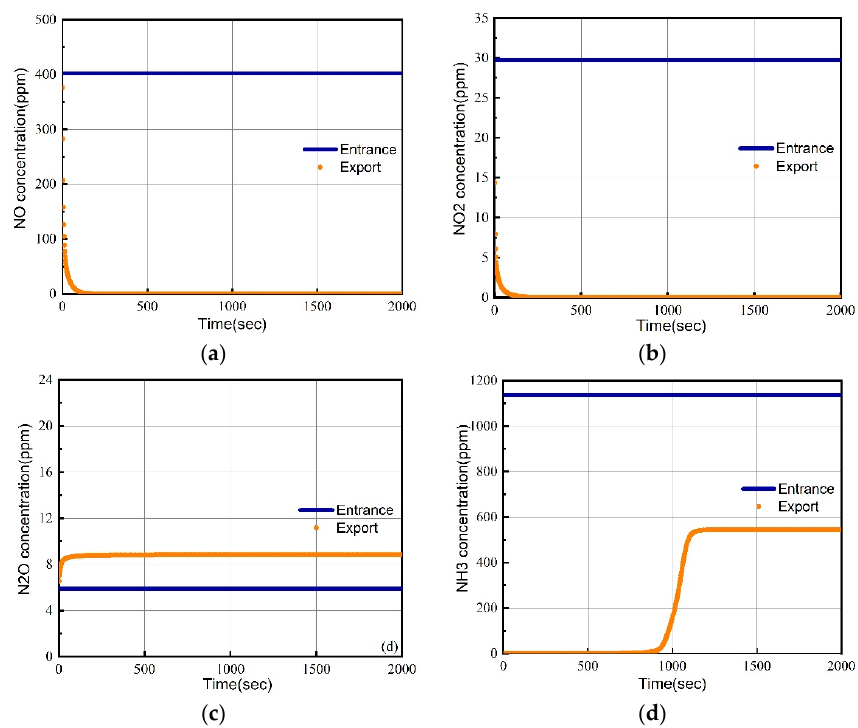
Figure 8. Comparison of NO X and unburned ammonia concentrations at SCR inlet and outlet in Case 1. ( a ) NO concentration on entrance and export. ( b ) NO 2 concentration on entrance and export. ( c ) N 2 O concentration on entrance and export. ( d ) NH 3 concentration on entrance and